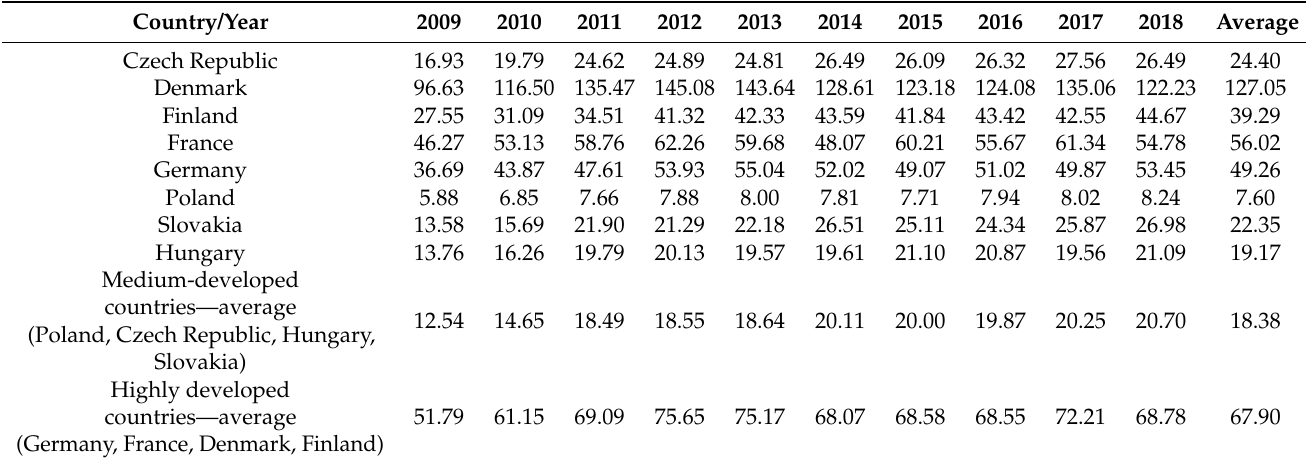
Table 7. Total income from agricultural production per labour input in agriculture of the surveyed EU countries (in euro per